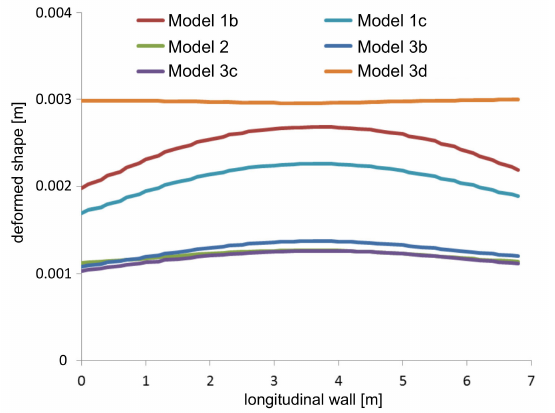
Figure 19. Deformed shape of the vault springer line in different models ( a x = 0.135 g).